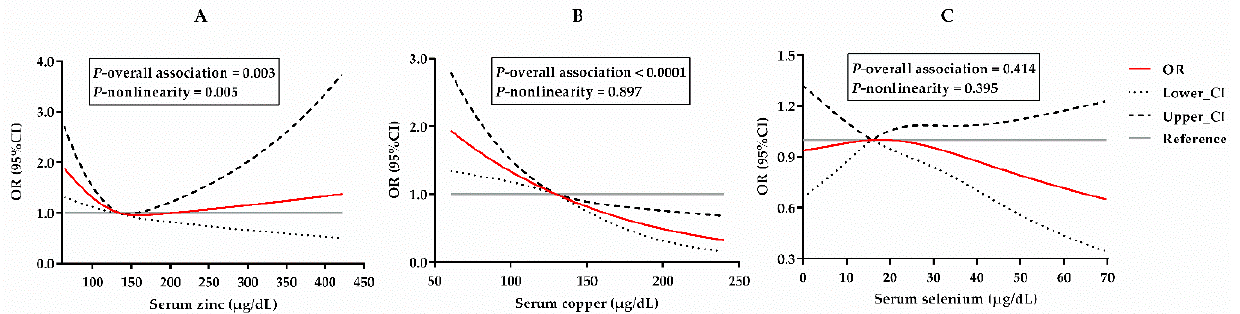
T2DM. The RCS curves reveal a non-significant selenium-T2DM association (Figure 1C, P overall association = 0.414) and a significantly negative linear copper-T2DM association (Figure 1B, P overall association < 0.0001, and P nonlinearity = 0.395). However, there was an L-shaped zinc-T2DM association (Figure 1A, P overall association = 0.003, P nonlinearity = 0.005), which indicated that serum zinc was inversely associated with T2DM at lower levels, while at higher levels, there was no significant association.